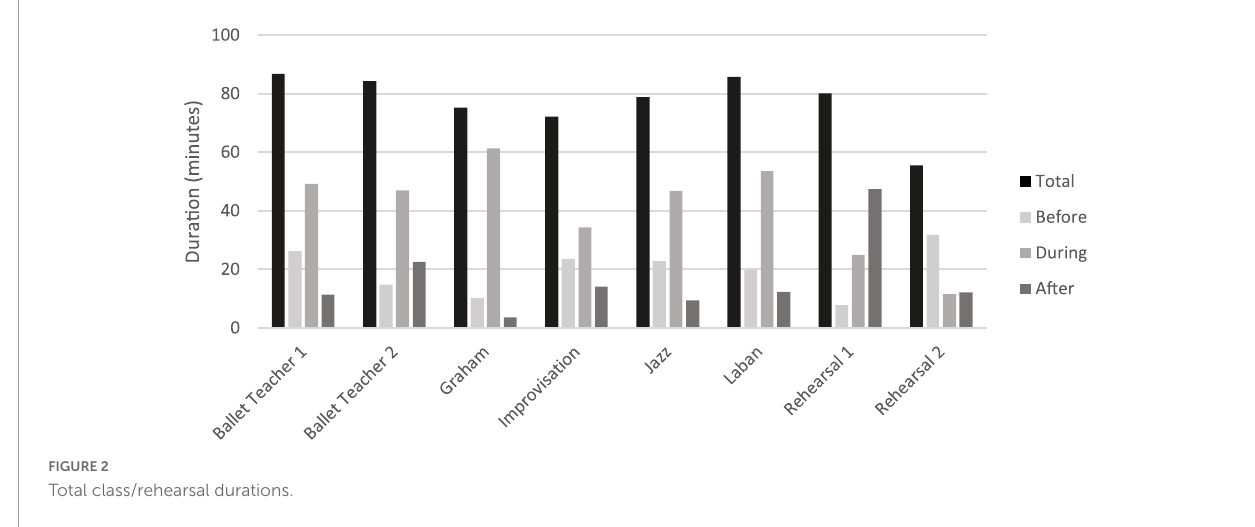
FIGURE2 Total class/rehearsal durations.